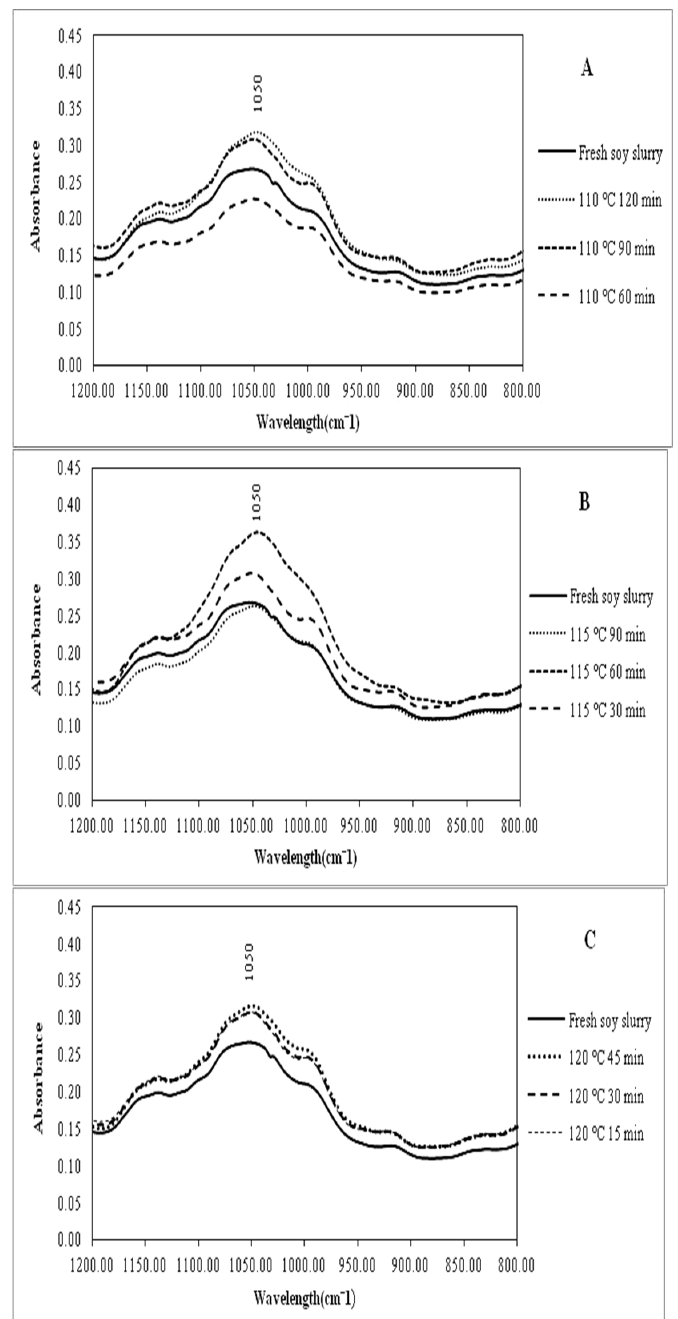
Figure 4. FTIR normalized spectra (1200–800 cm − 1 ) of soy slurry samples processed at ( A ) 110 °C, ( B ) 115 °C and ( C ) 120 °C.